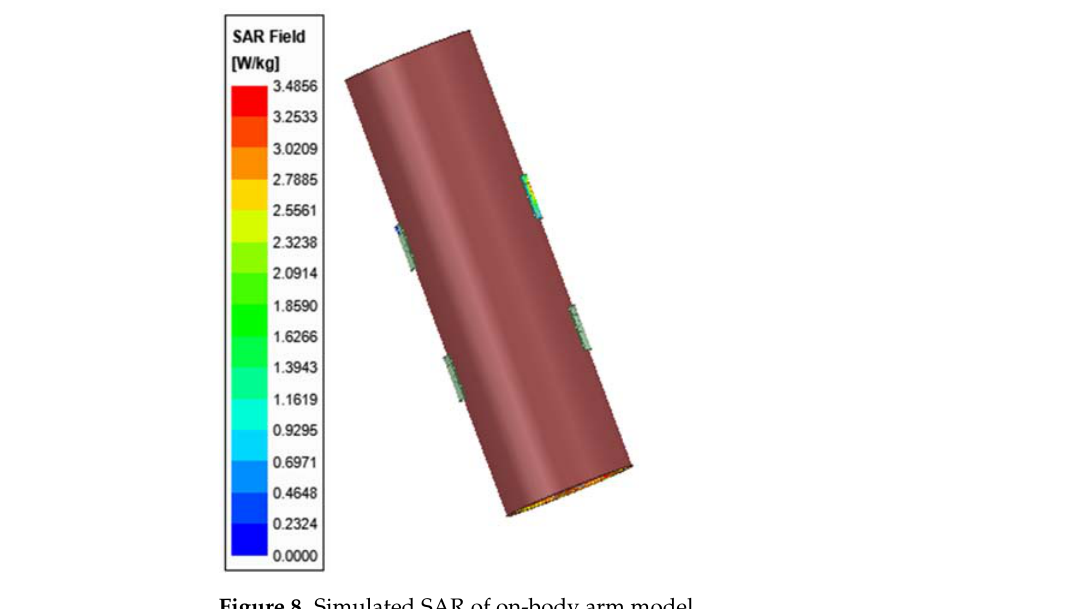
Figure 8. Simulated SAR of on-body arm model.